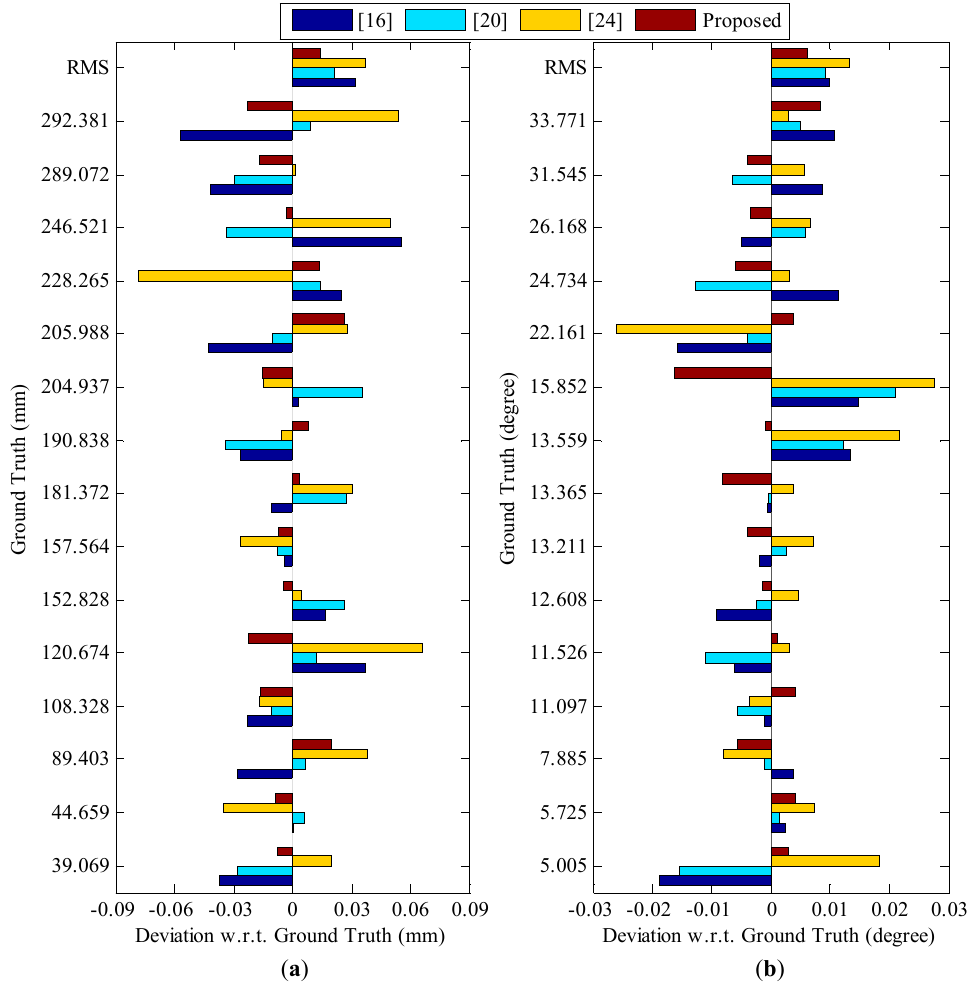
Figure 14. Measurement results of ( a ) displacement d and ( b ) attitude angle θ .